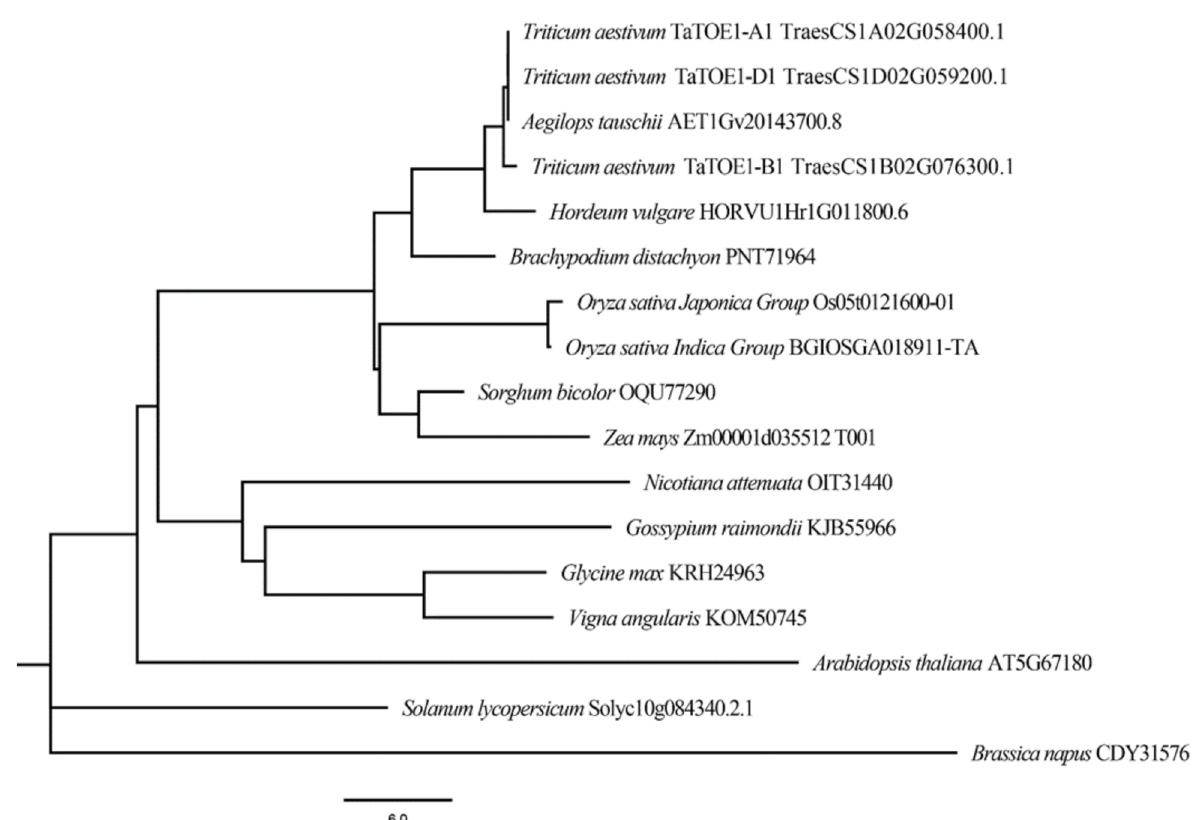
Figure 2. Phylogenetic tree constructed by neighbor-joining (NJ) method (bootstrap = 1000). Species name and protein ID of homologous proteins shown at ends of